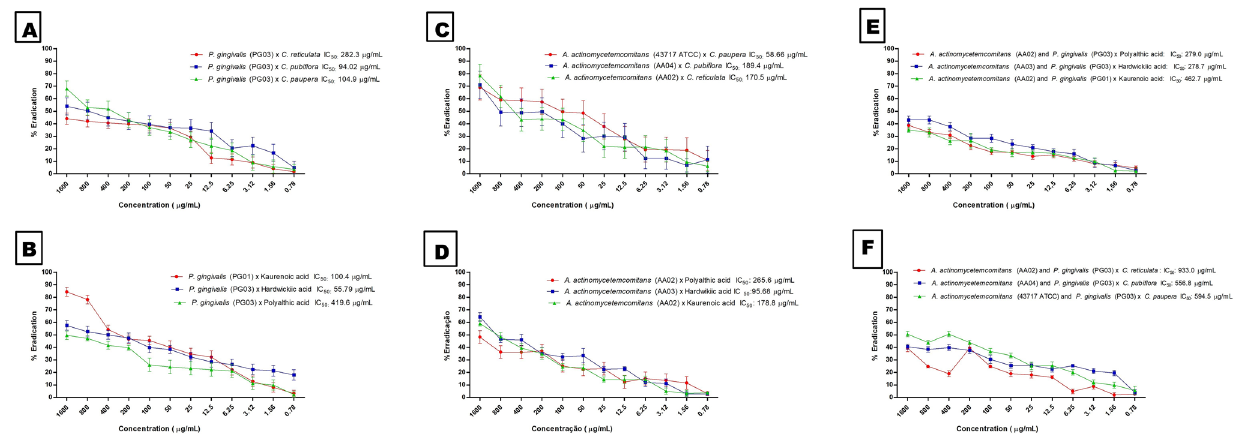
Figure 3. Biofilm eradication of A. actinomycetemcomitans and P. gingivalis in the monospecies ( A , B , C , D ) and multispecies ( E , F )